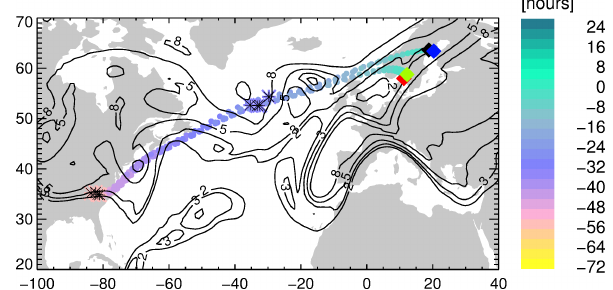
Figure 11. Geographical position of four forward trajectories from 7 August at 12:00 UTC to 9 August at 12:00 UTC (coloured dots) based on 2-day backward trajectories from CLaMS ice events over Scandinavia (IWC>0 and altitudes above the tropopause) on 9 Au- gust at 12:00 UTC (reference time for Fig. 12). CLaMS ice events are highlighted by coloured diamonds in red, green, blue, and black. Crosses mark the position on 7 and 8 August at 12:00 UTC. PV con- tours are presented at (cid:50) =350K for 9 August at 12:00